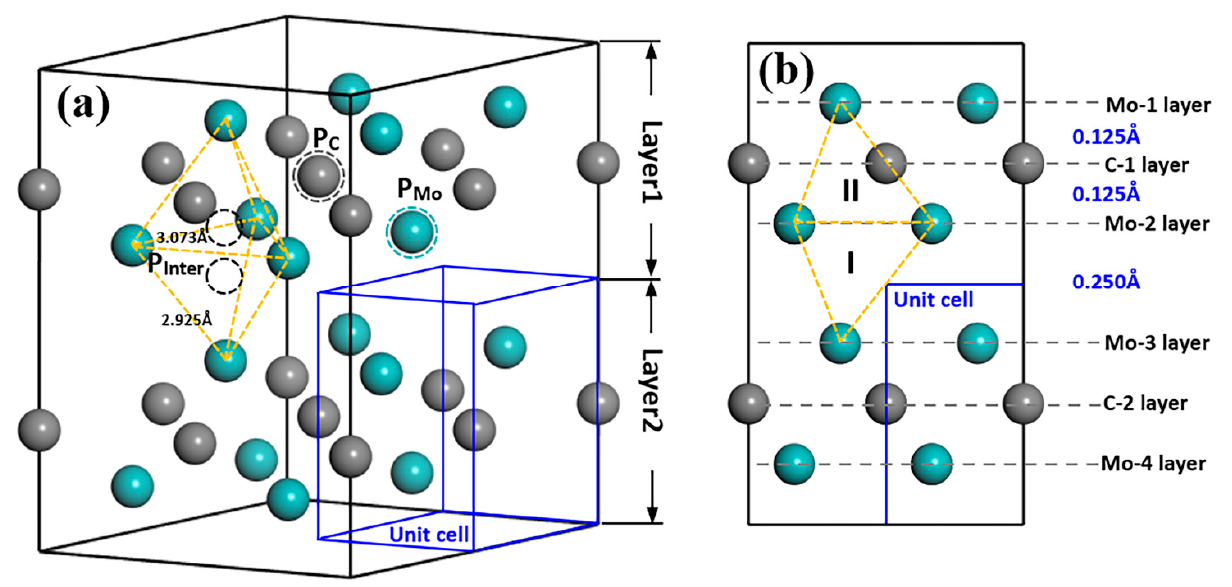
Figure 1. Schematic diagram of Mo 2 C structure of 2 × 2 × 2 supercell ( a ) and along [21 (cid:3364) 1 (cid:3364) 0] direction ( b ). Cyan and grey balls represent Mo and C atoms; cyan and grey dashed circles are the positions that are used to form vacancy and substitution defects; yellow dashed frames are the tetrahedrons that Mo atoms formed inside the layer (type II) and between two layers (type I) and the black dashed circles are the tetrahedral position inside the tetrahedrons; blue frame refers to the Mo 2 C unit cell. P Mo and P C represent the positions of the Mo and C atoms, while P Inter refers to the position for in- terstitial atoms in the structure.